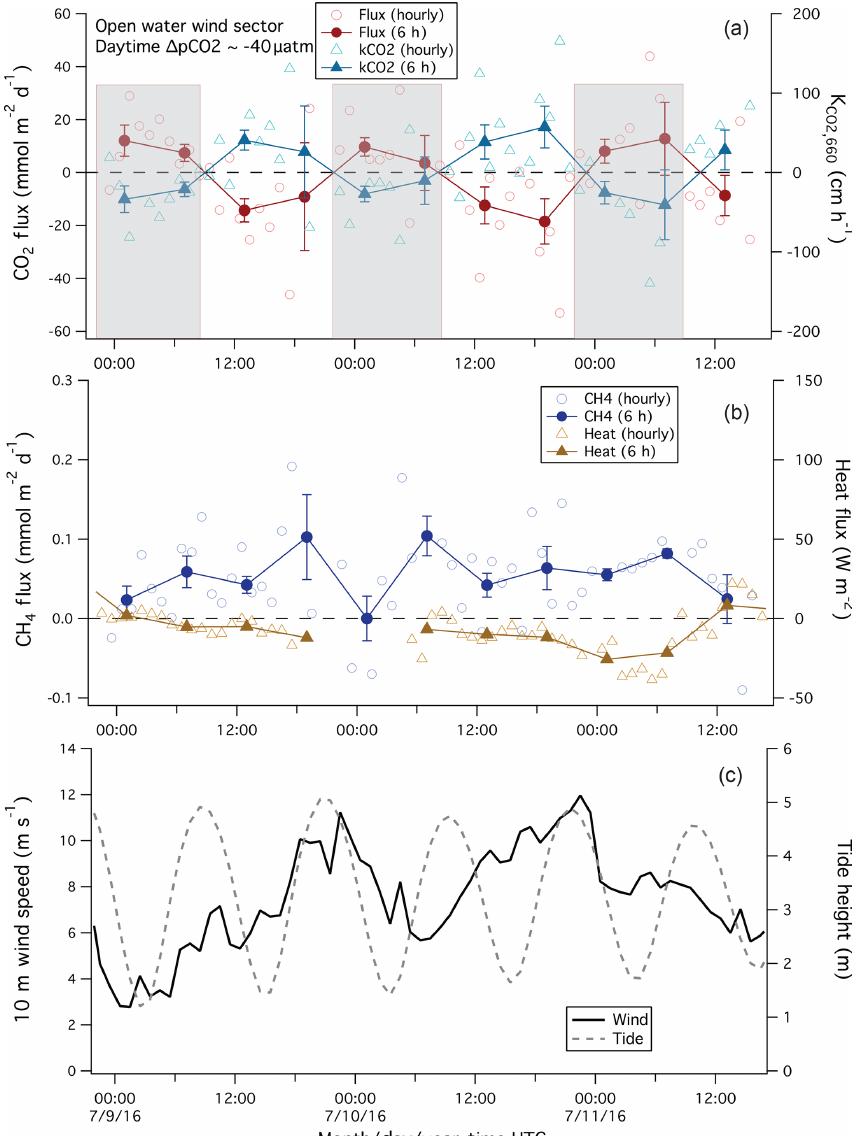
Figure 6. Example of variability in: (a) CO 2 flux and computed transfer velocity; (b) CH 4 flux and sensible heat flux; and (c) wind speed and tidal height during a period of southwesterly winds. Fluxes are shown in both hourly and 6h averages. Note that the negative transfer velocity ( K ) values at night (shaded) computed from the measured CO 2 flux and interpolated daytime p CO 2 are non-physical, and likely due to unaccounted for diurnal variability in seawater p CO 2